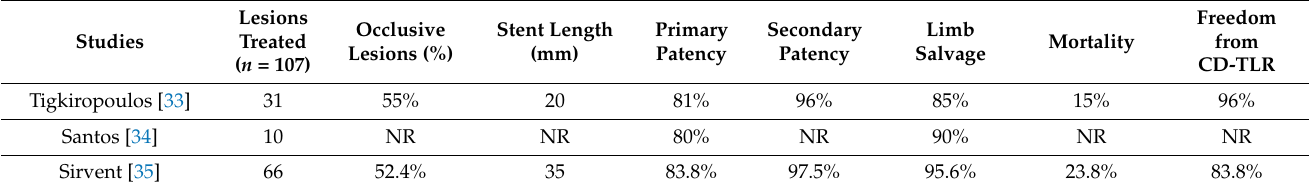
Table 3. Clinical outcomes of polymer free amphilimus eluting stent in 3